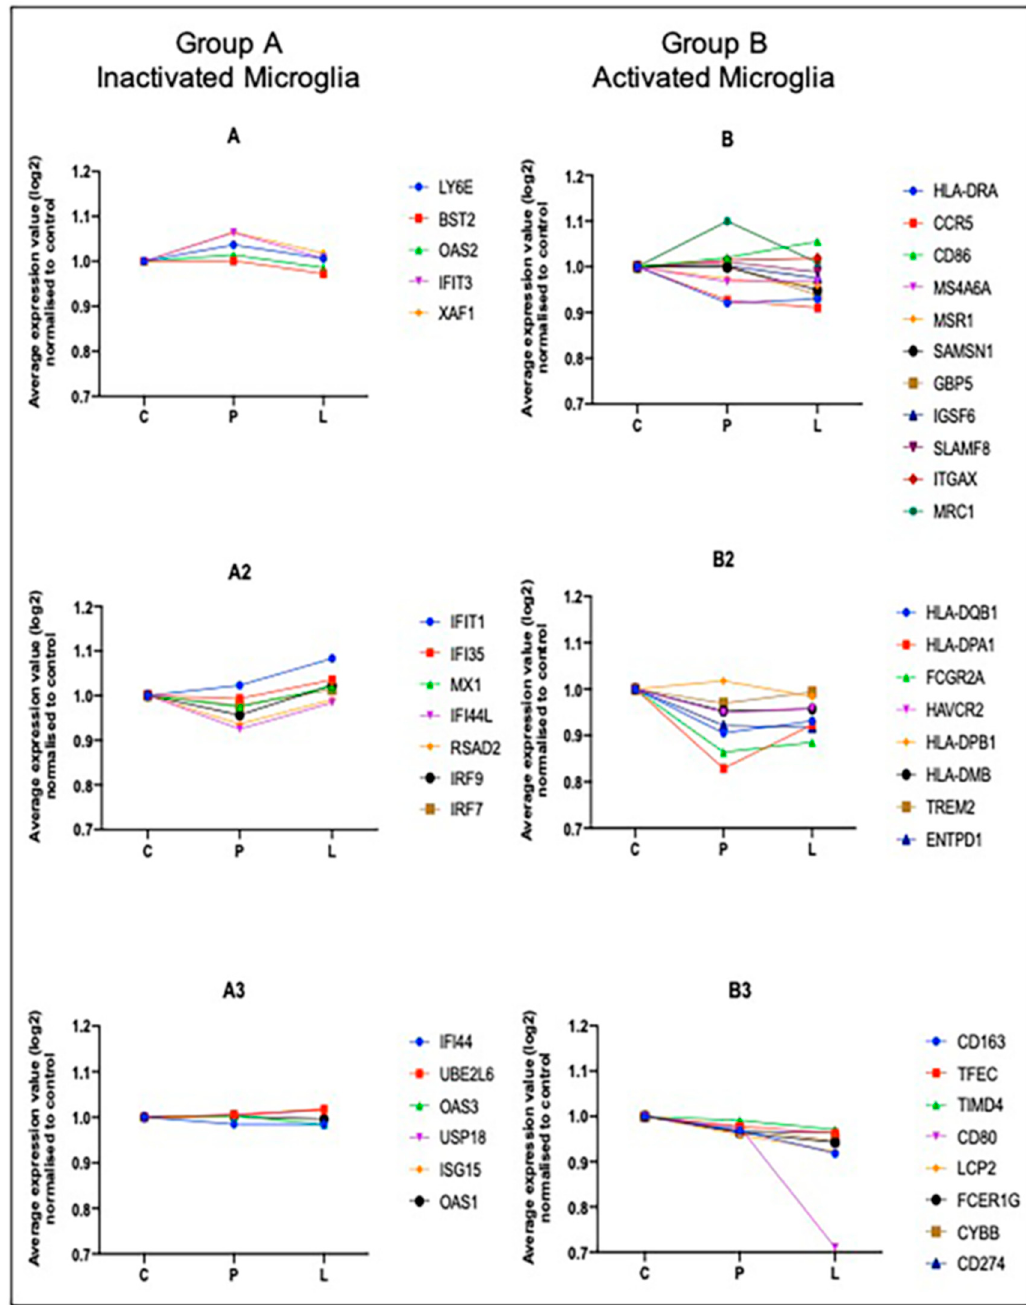
Figure 3. Graphical representation of gene annotations in activated and inactivated microglia in ageing periventricular white matter. BST2 was used to identify the co-expressed genes associated with inactivated microglia ( A – A3 ). For activated microglia, TREM2 , HLA-DRA , ENTPD1 , CD80 , CD86 , CCR5 , CD274 , ITGAX , TIMD4 and MRC1 were selected ( B – B3 ). C: non-lesional control white matter; P: “pre-lesional”; L: periventricular lesion.